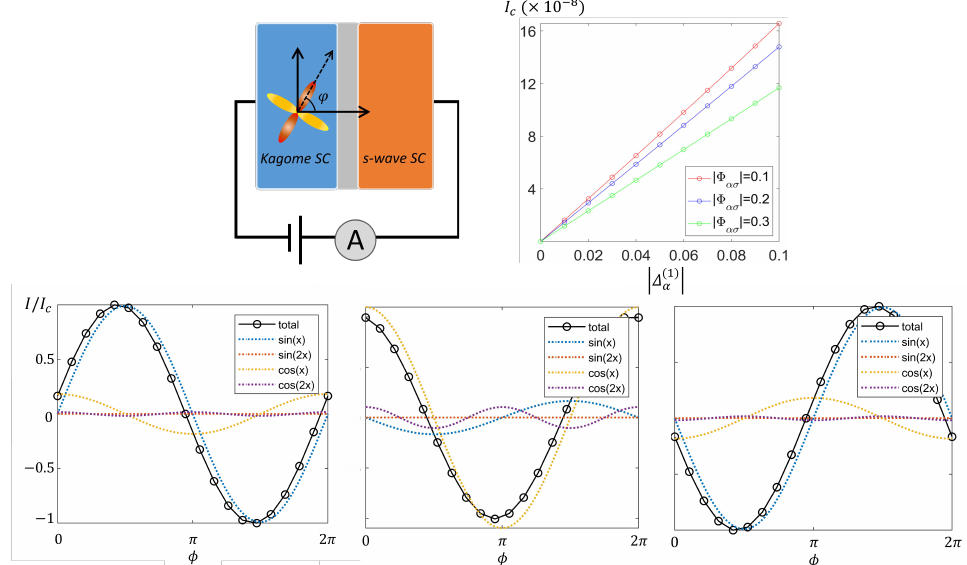
Figure 7: Spectral functions of BdG Hamiltonian, Eq. (35) with an open boundary condition for ( Φ ( Φ ) = ( − i , i , i ) , and ( Φ , Φ , Φ 1 ↓ 2 ↓ 3 ↓ the order parameters are | Φ ασ | = 0.3, | ∆ α | = 0.1.